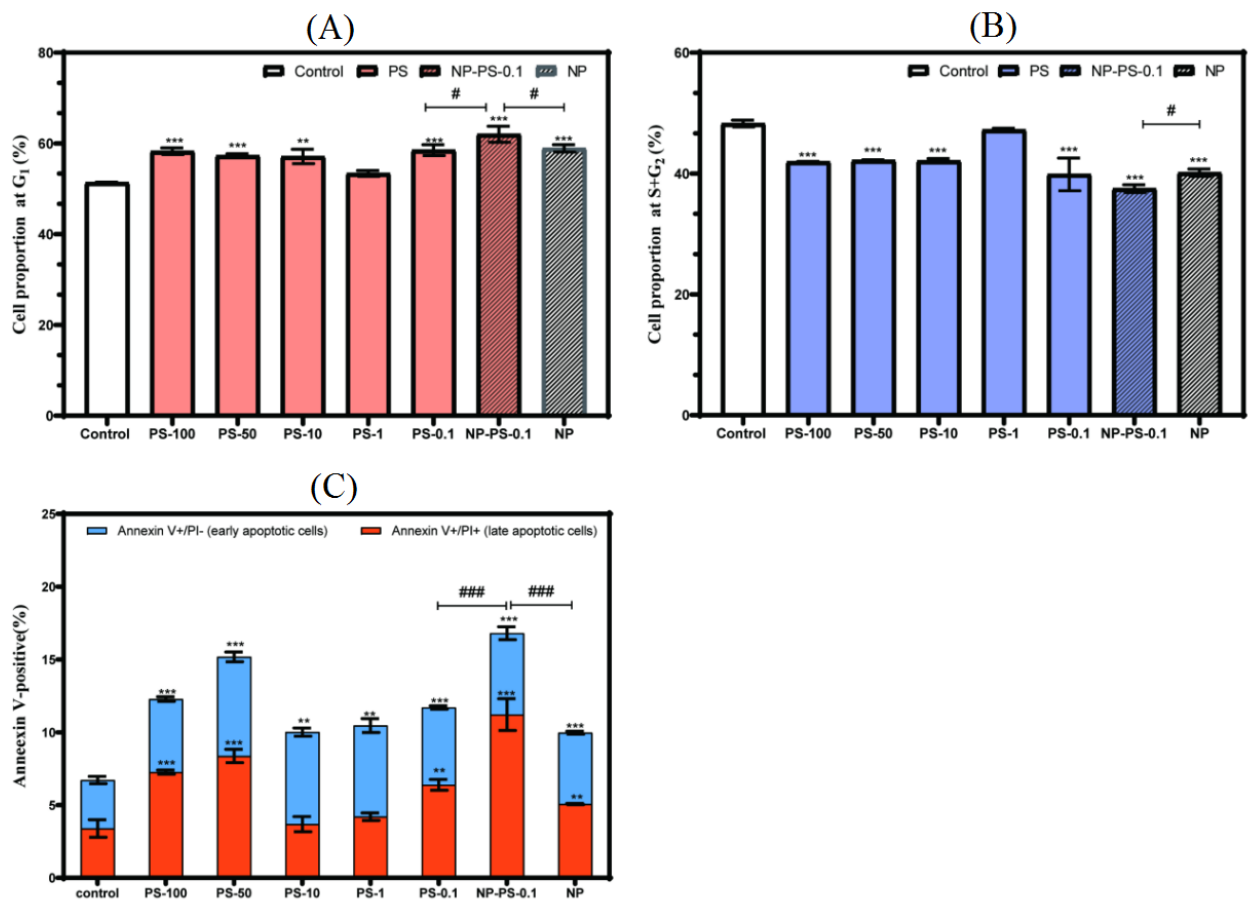
Figure 5. Effects of 48 h treatment of PS-MPs, NP and synergistics on the cell cycle and apoptosis of the Caco-2 cells. ( A ) Shows the proportion of cells in the G1 phase via different exposures. ( B ) Showed the sum of the cells in the S and G2 phases via different exposures. Early and late apoptotic Caco-2 cells were analyzed by flow cytometry after Annexin V and PI staining. A statistical graph of the percentage of cells in each phase was calculated ( C ). * indicates the significant difference between the treatment group and the control group (** p < 0.001, *** p < 0.0005). # indicates the significant difference between the marked groups ( # p < 0.05, ### p < 0.0005).